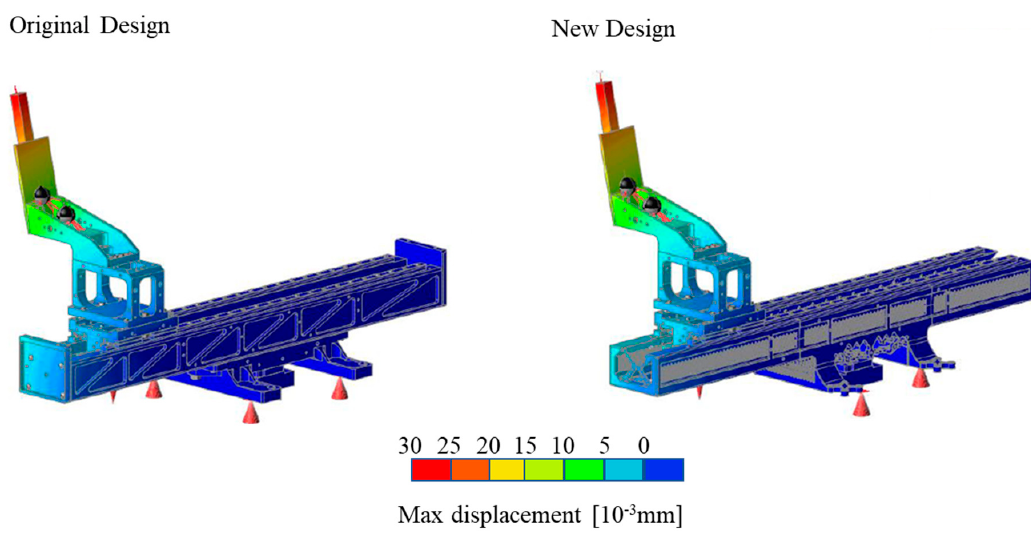
Figure 7. Comparison of the maximum displacements between the original and the new design. The maximum displacement is registered as the extremity of the probe. The slight difference in the displacements values between the two designs demonstrates that the stiffness of the system has been preserved while the material efficiency has been improved.